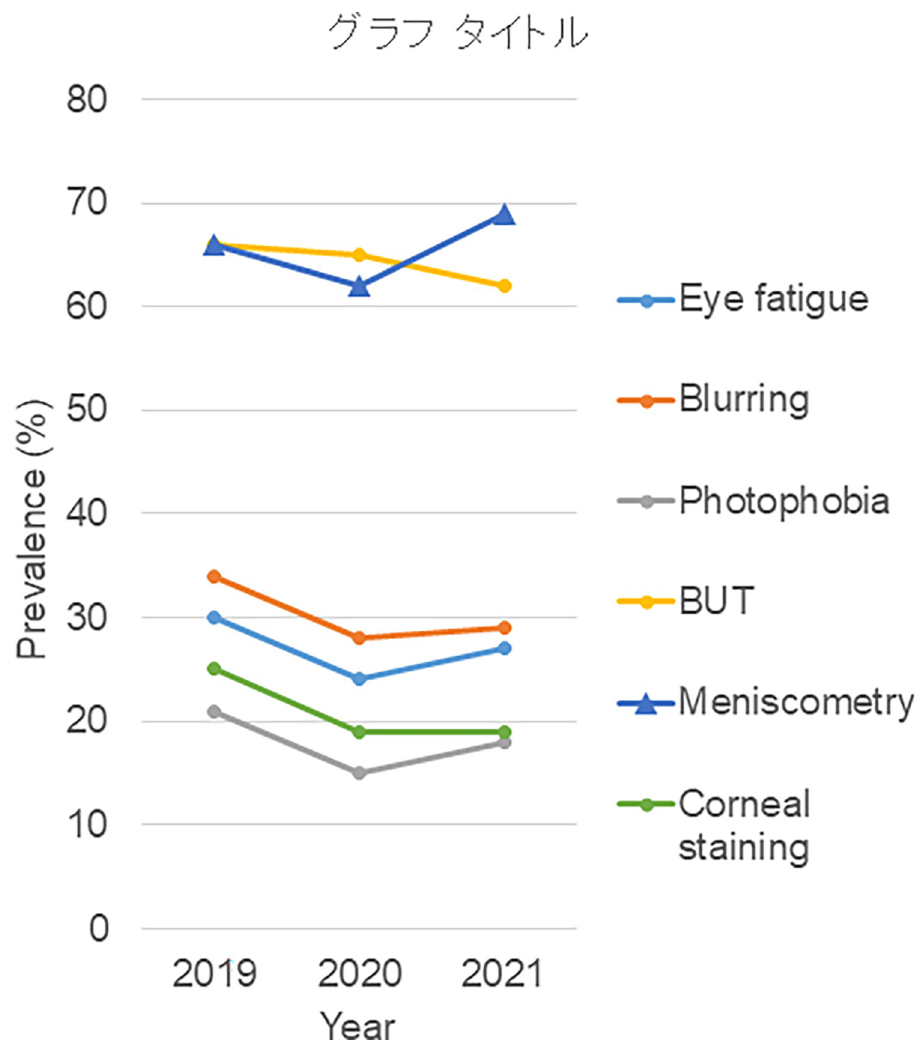
Fig 1. Prevalence of ocular signs and symptoms from the year 2019 to 2021. Overall prevalence decreased in 2020. Prevalence of eye fatigue, blurring, photophobia and low meniscometry values ( � 2.5mm) increased in 2021, whilst two parameters of corneal epithelial cells, BUT ( � 5mm) and corneal staining, did not increase in 2021. BUT, tear break-up